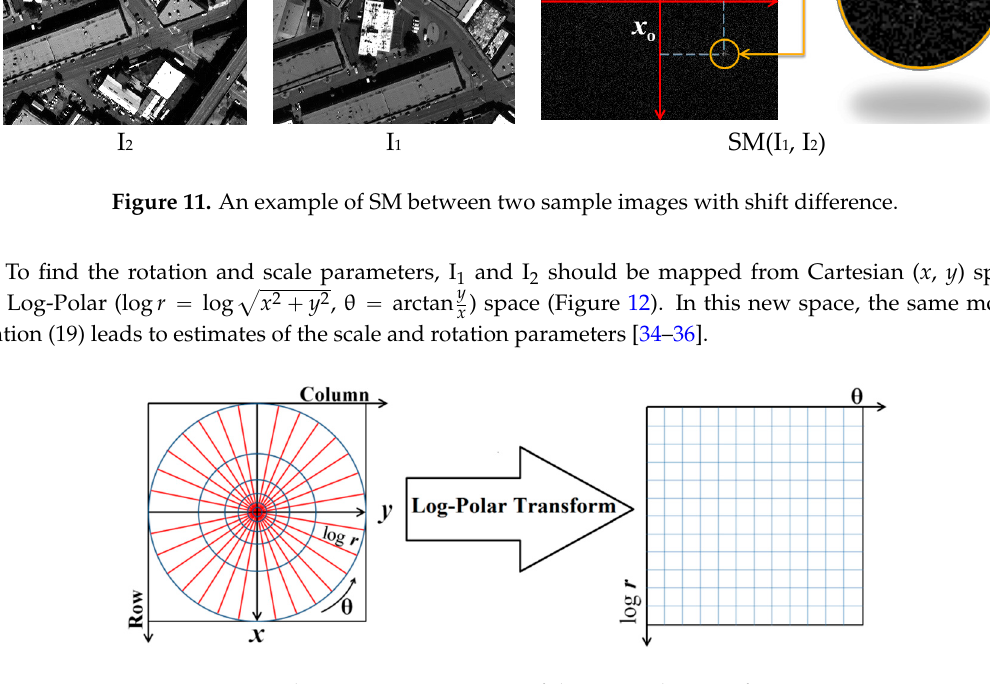
Figure 12. Schematic representation of the Log-Polar transformation.